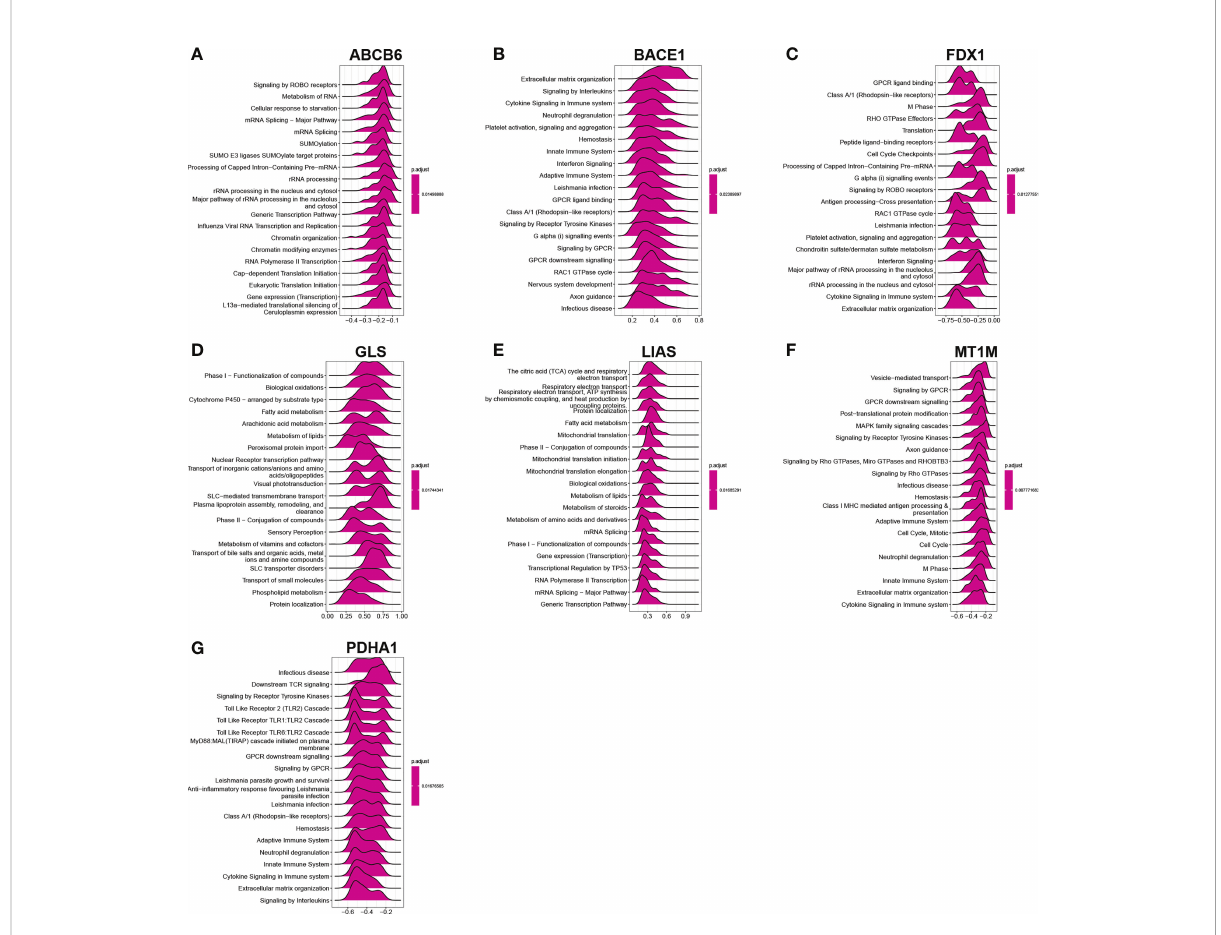
FIGURE 7 GSEA investigation of ABCB6, BACE1, FDX1, GLS, LIAS, MT1M, and PDHA1 (A – G)